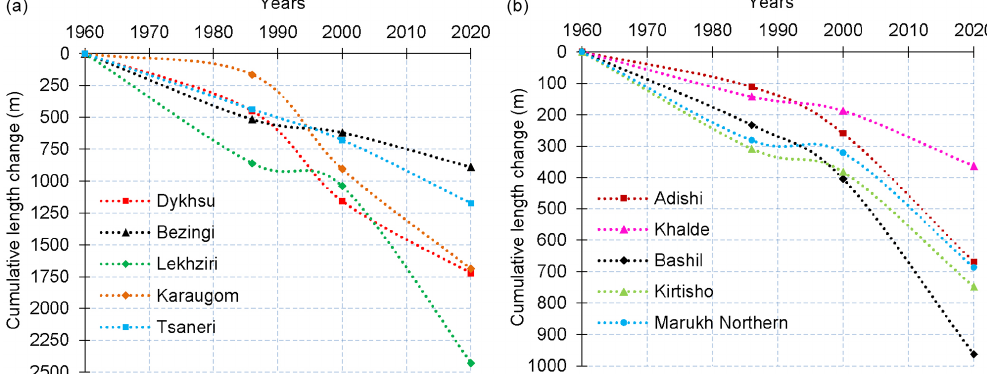
Figure 10. Comparison of cumulative curves of terminus changes in 1960–2020: (a) for glaciers with size class > 10km 2 and (b) for glaciers with size class 5–10 and 1–5km 2 . In both panels the dotted lines only connect the four measurement points. Data for 1960 and 1986 were taken from Tielidze and Wheate (2018).